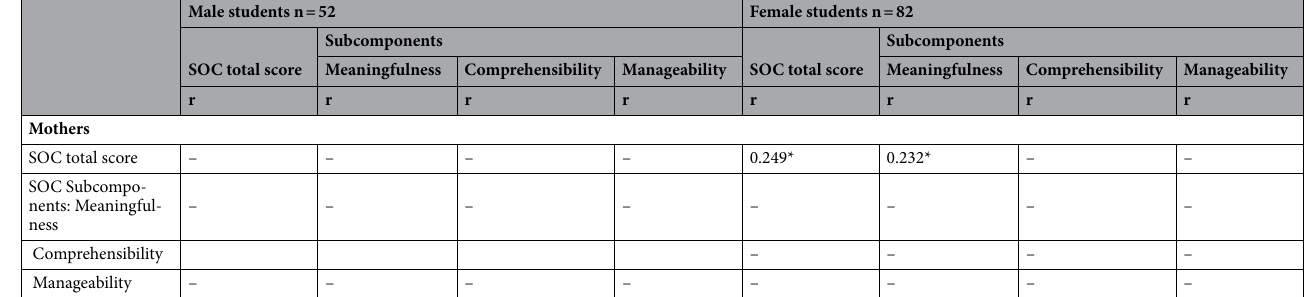
Table 2. SOC correlation of mother and child by gender. Variables that did not show significant differences were excluded. SOC sense of coherence. * p <